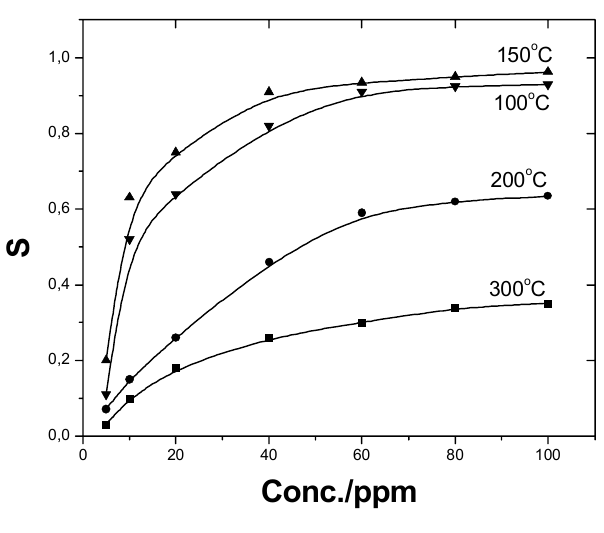
S gas concentration at 2